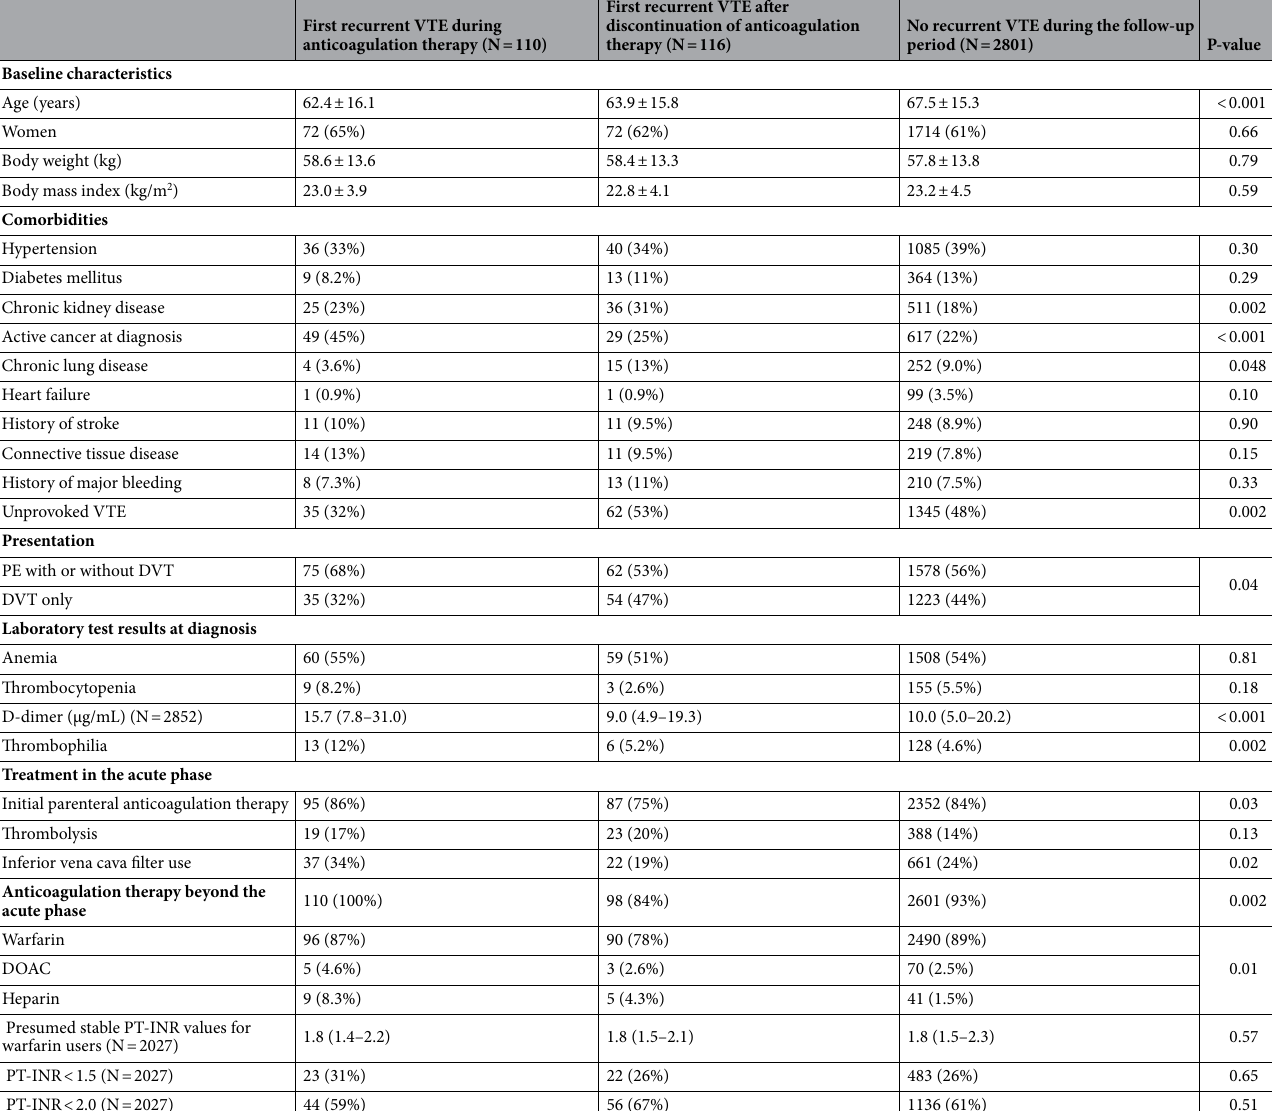
Table 1. Patient characteristics. Categorical variables are presented as numbers and percentages, and continuous variables are presented as the mean and standard deviation or the median and interquartile range based on their distributions. Categorical variables were compared using the chi-squared test when appropriate; otherwise, Fisher’s exact test was used. Continuous variables were compared using one-way analysis of variance or Kruskal–Wallis test based on their distributions. Chronic kidney disease was diagnosed if there was persistent proteinuria or if estimated glomerular filtration rate was < 60 mL/min/1.73 m 2 for more than 3 months. Patients with active cancer were defined as those on treatment for cancer such as chemotherapy or radiotherapy, those scheduled to undergo cancer-surgery, those with metastasis to other organs, and/or those with terminal cancer (expected life expectancy of 6 months or less) at the time of the diagnosis. Unprovoked VTE was defined as VTE without active cancer nor transient risk factors for VTE. Anemia was defined as hemoglobin level < 13 g/dL for men and < 12 g/dL for women. Thrombocytopenia was defined as platelet count < 100 × 10 9 /L. Thrombophilia included protein C deficiency, protein S deficiency, and antithrombin deficiency. The values of presumed stable INR for warfarin users was evaluated as the first INR between 1 and 6 months after VTE diagnosis, and if there was no available INR between 1 and 6 month after VTE diagnosis, it was regarded as missing. VTE venous thromboembolism, DVT deep vein thrombosis, PE pulmonary embolism, DOAC direct oral anticoagulant, PT-INR prothrombin time-international normalized